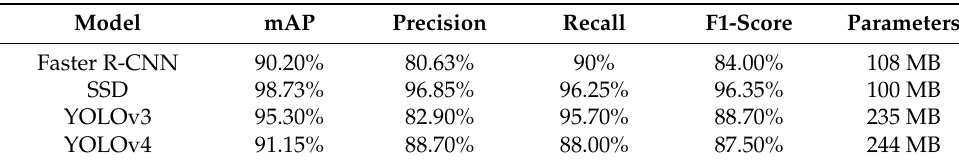
Table 1. Comparison of different network detection results.